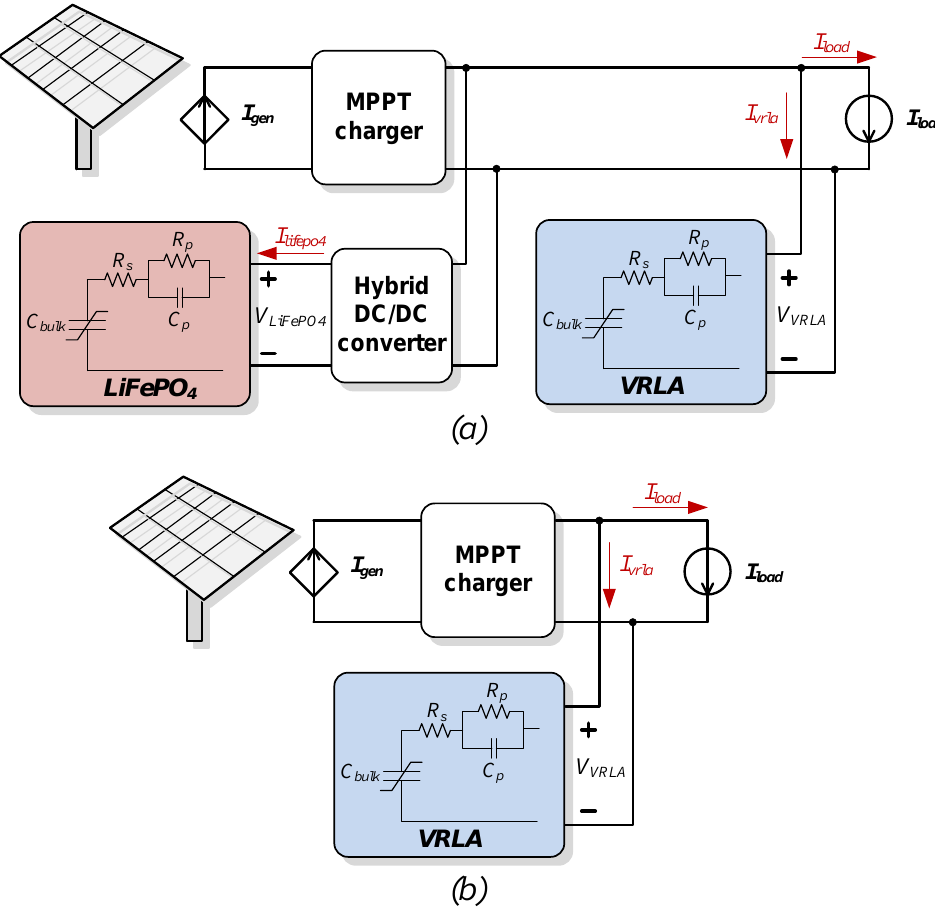
Figure 7. Circuital simulation scheme.